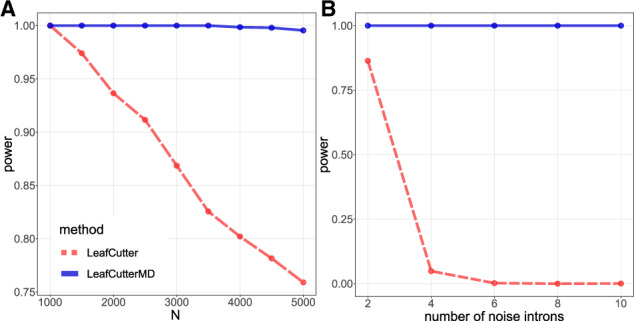
The proposed method retains power even as the number of irrelevant reads N is increased, whereas the original LeafCutter method experiences a decrease in power. In (A), the reads are all placed in a single noise intron, whereas in (B), there is an increasing number of noise introns each receiving 500 additional reads on average